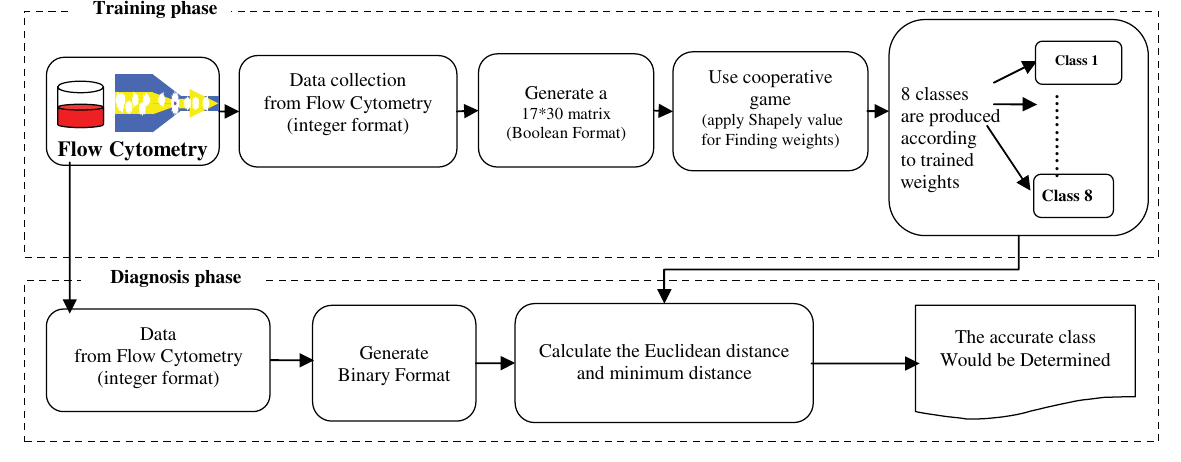
Fig. 3. System proposed based on cooperative game to classify